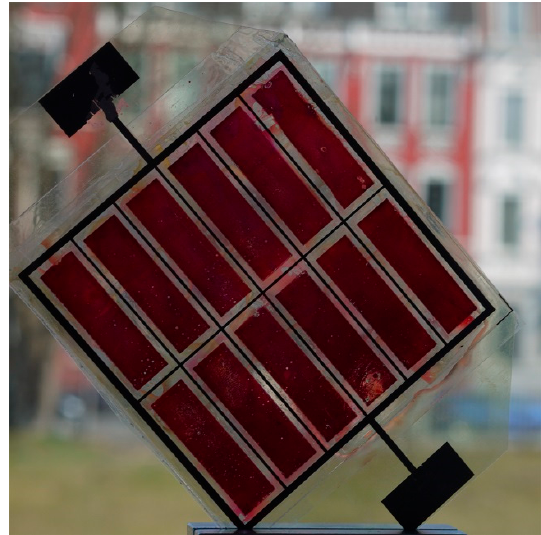
Figure 7. Functional flexible DSSC module with a photoactive area of 34.56 cm 2 . ITO-PET foils are used as substrates for the photo-anode and the counter electrode. The photo-anode contains electrodeposited ZnO films with a thickness of about 9 µm.